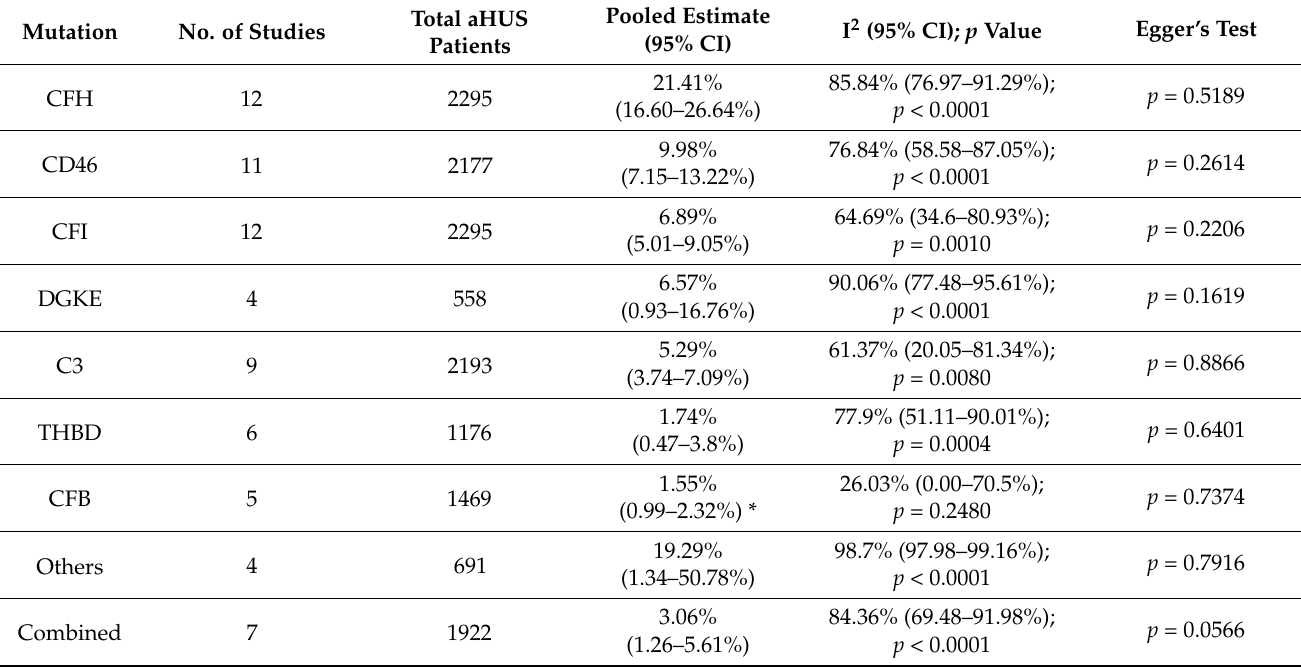
Table 1. Pooled proportion of different mutations in aHUS